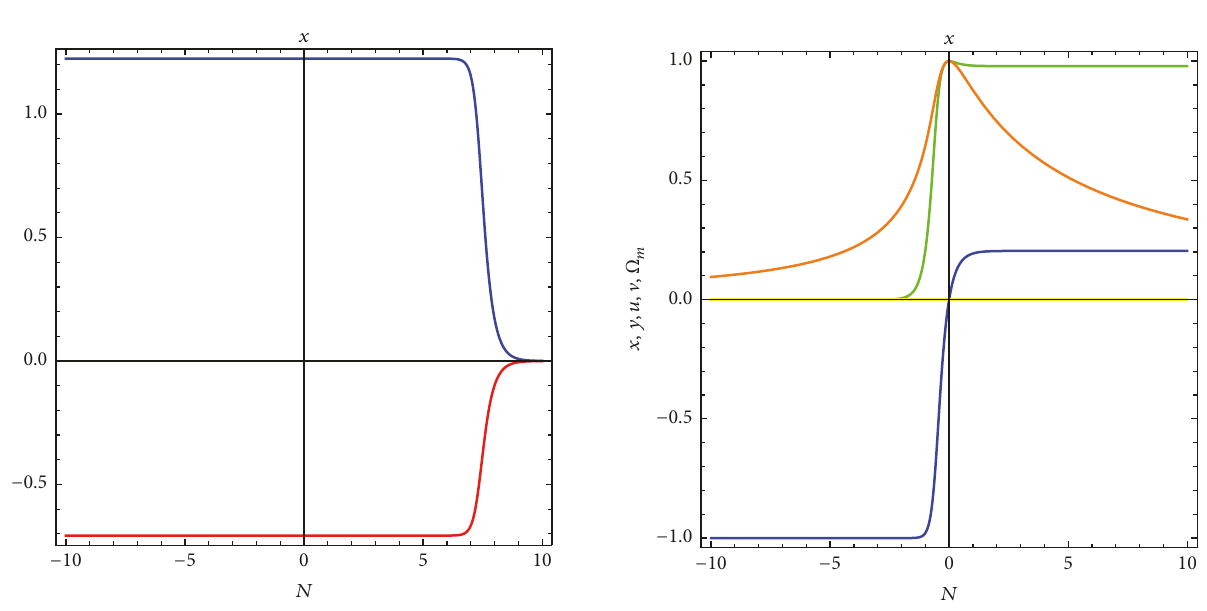
Figure 5: Plot of ( 5 ) variations of 𝑥 (blue), 𝑦 (green), 𝑢 (orange), Figure 7: Plot of ( 7 ) variations of 𝑥 (blue), 𝑦 (green), 𝑢 (orange), V (red), and Ω 𝑁 near 𝑃 𝛾 = 1 , 𝛿 = 1 , and V (red), and Ω 𝑁 near 𝑃 𝛾 = 0 , 𝛿 = 1 , and 푚 (yellow) versus 6 , for 푚 (yellow) versus 8 , for 𝜆 = −0.5 . The position corresponding to 𝑁 = 0 is the fixed point 𝜆 = −0.5 . The position corresponding to 𝑁 = 0 is the fixed point under consideration. under